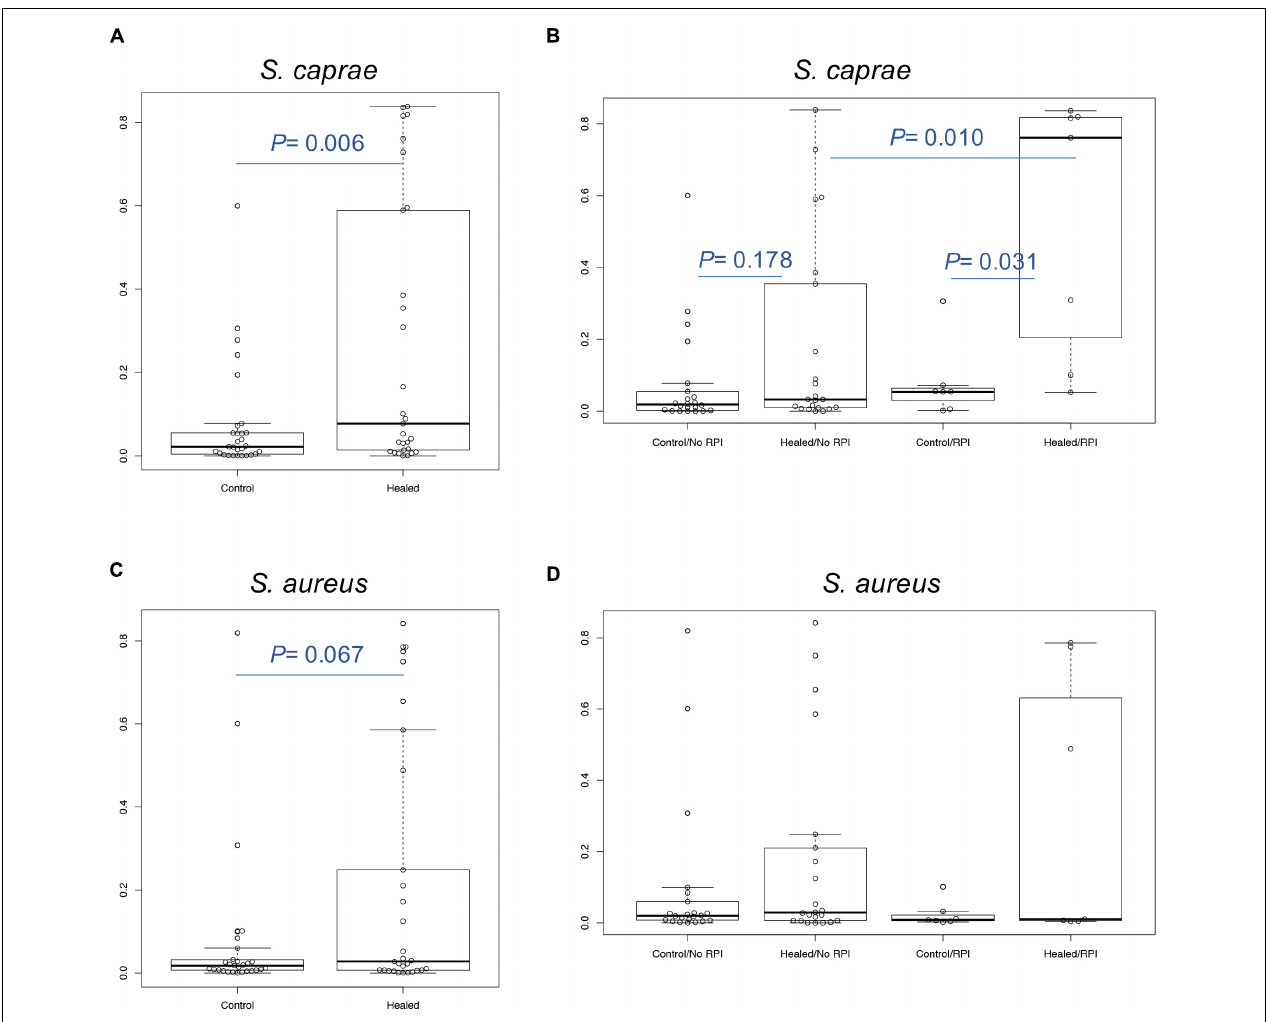
FIGURE 2 | Relative abundance of S. caprae and S. aureus . Comparison of (A) S. caprae and (C) S. aureus abundance between control sites (including non-RPI and RPI) and healed sites. P -values were calculated by Welch’s t -test. (B) Comparison of S. caprae and the four groups. After the Kruskal–Wallis test ( p = 0.006), Bonferroni correction was calculated for statistical significance. (D) Comparison of S. aureus and the four groups. No significance was detected by the Kruskal–Wallis